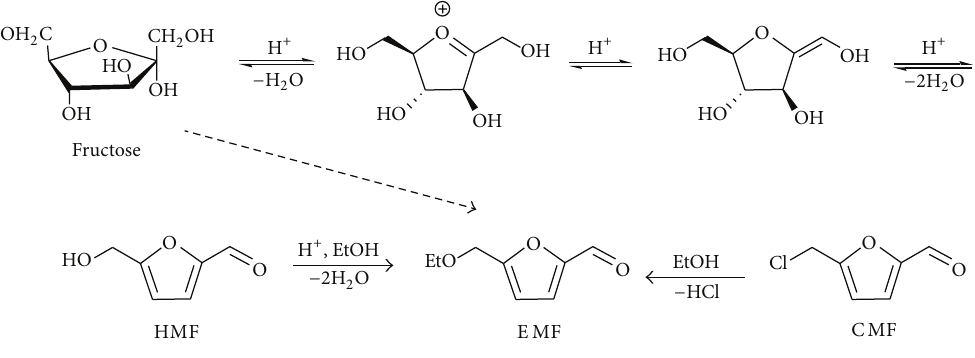
Scheme 1: Synthesis of EMF from CMF, HMF, and